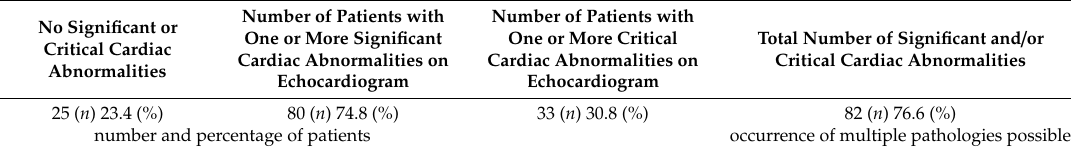
Table 4. Incidence of cardiac abnormalities detected by expert critical care echocardiography